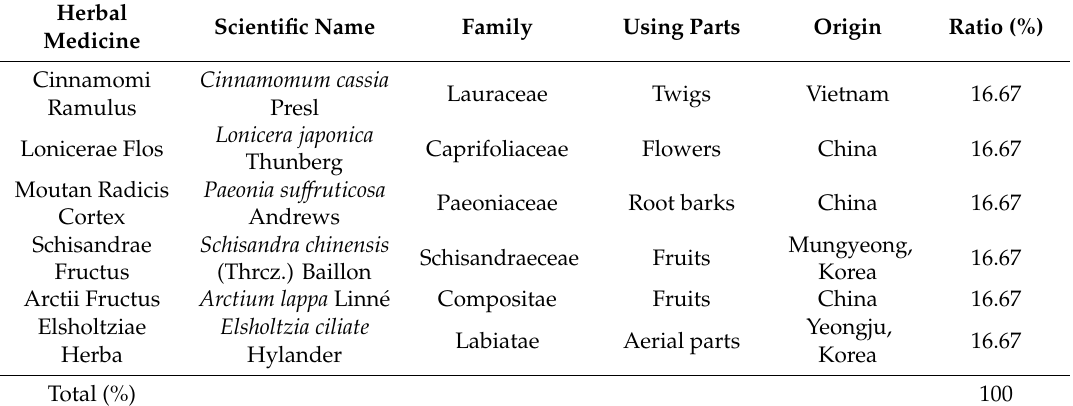
Table 1. Composition of